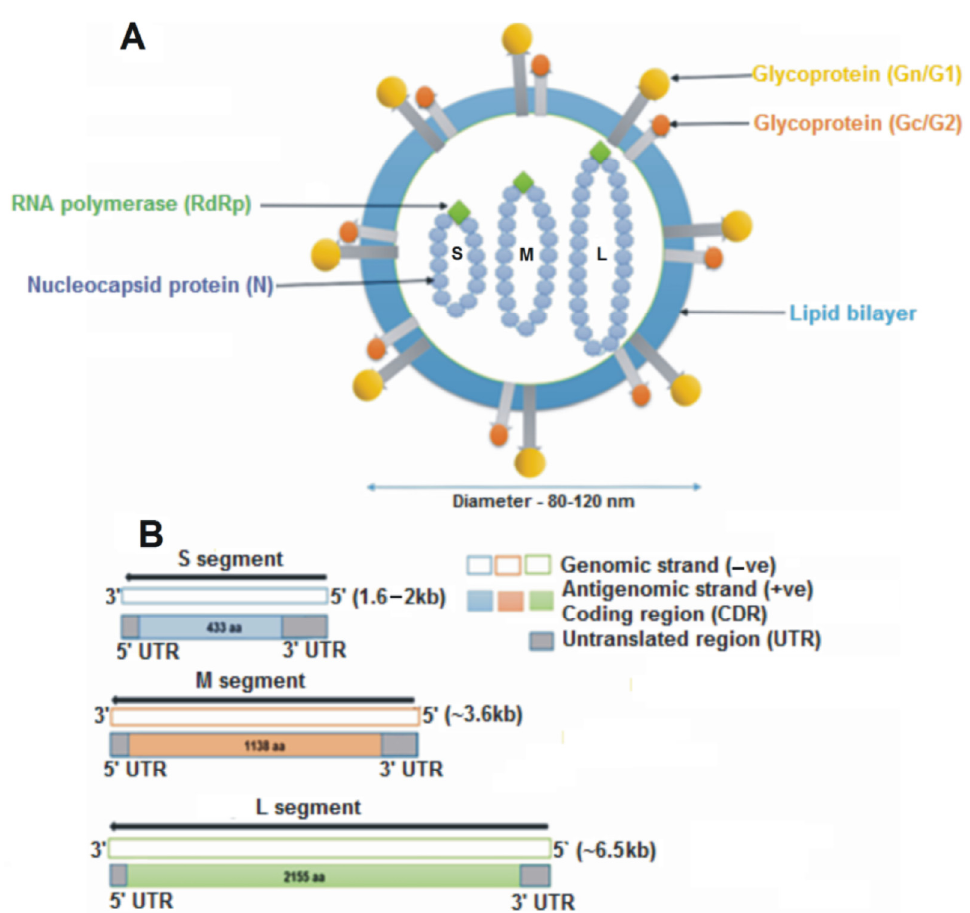
Figure 1. Schematic representation of an orthohantavirus virion. ( A ) The structure is spherical, having a diameter of 8–120 nm, enveloped with a lipid bilayer containing spikes of glycoproteins (Gn and Gc). Inside the virion are three segments of single-stranded RNA: small (S), medium (M) and large (L). ( B ) The S, M, and L genomic segments encode for the nucleocapsid protein (433 aa), glycoprotein precursor (1138 aa) and the RNA-dependent RNA polymerase (2155 aa), respectively.